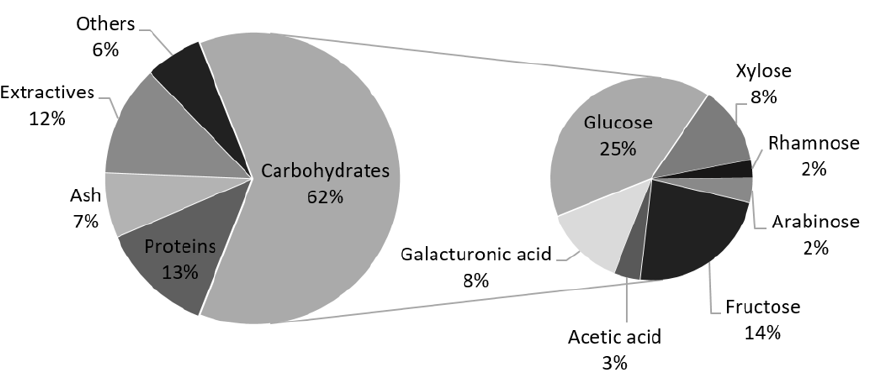
Figure 1. Proximal composition of artichoke bracts. The information of carbohydrates found for artichoke bracts is limited, but Pesce et al. [25] identified in the “Spinoso sardo” artichoke genotype, 23.62% glucans and 17.70% hemicelluloses composed by 12.57% xylose, 3.35% arabinose and 1.79% acetic acid, compa- rable to the values reported in this